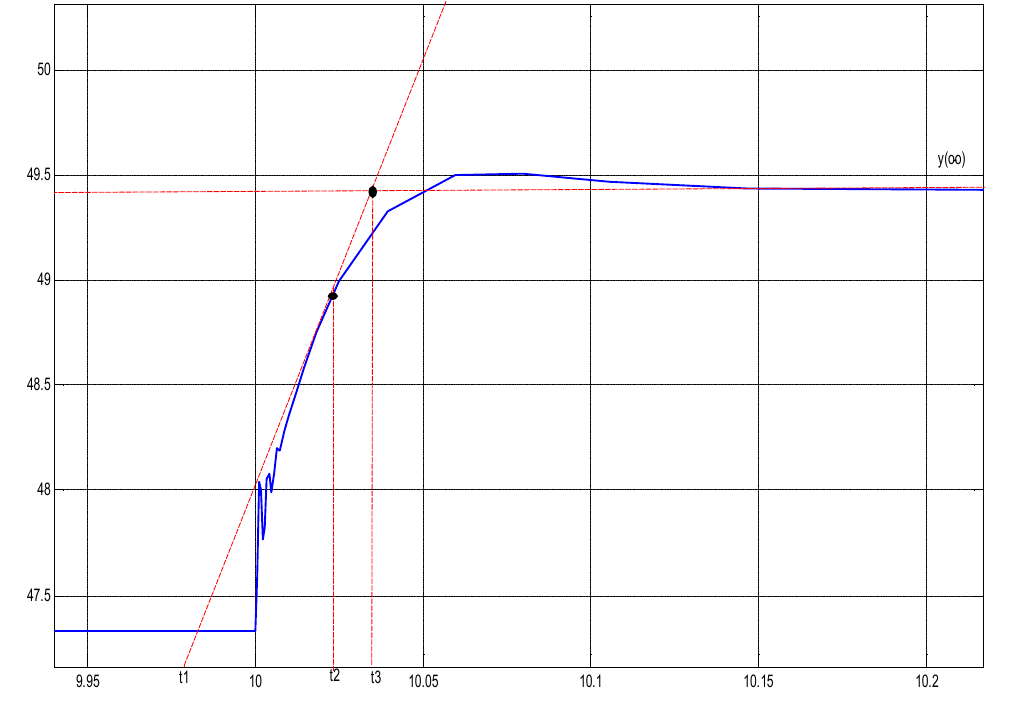
Figure 19. Indicial response of the process.